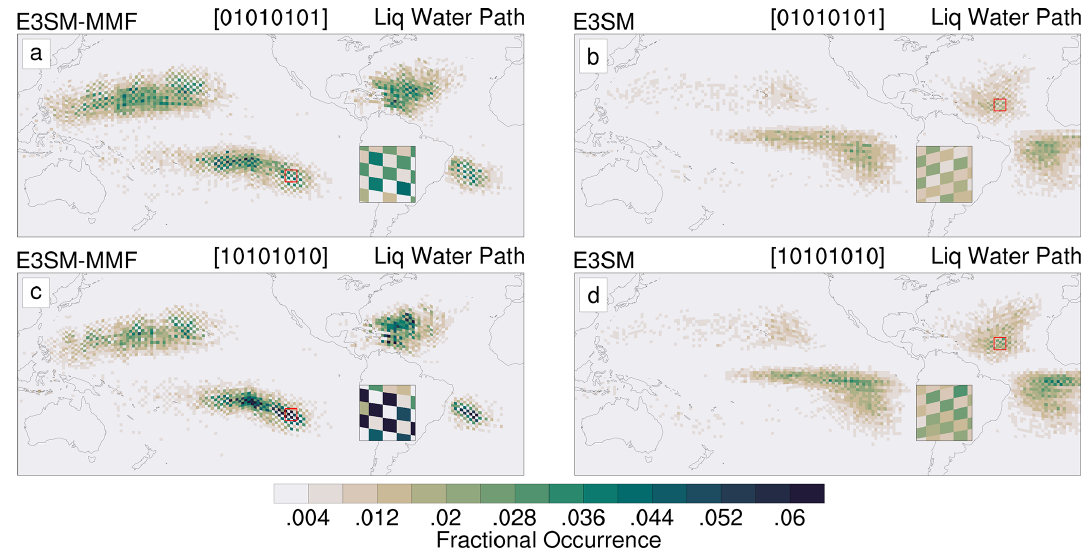
Figure 10. Maps of each unique phase of the pure checkerboard pattern in E3SM-MMF (a, c) and E3SMv2 (b, d) . The map inset shows an arbitrarily chosen small region to highlight the “out of phase” nature of the phases, indicating a lack of translational